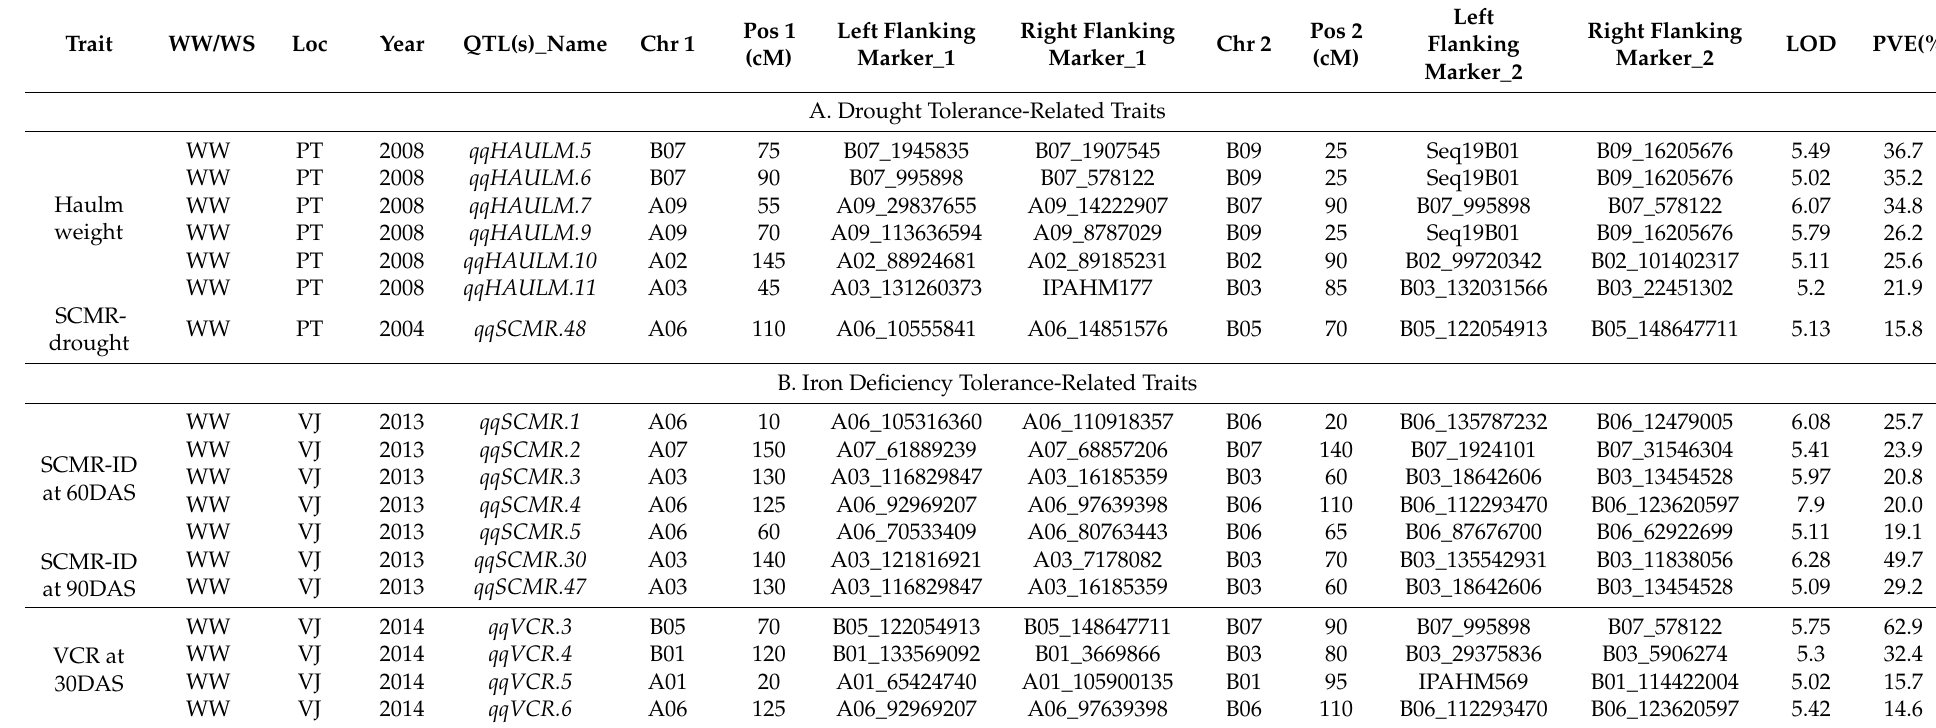
Table 5. Major epistatic QTLs for drought tolerance- and iron deficiency tolerance-related